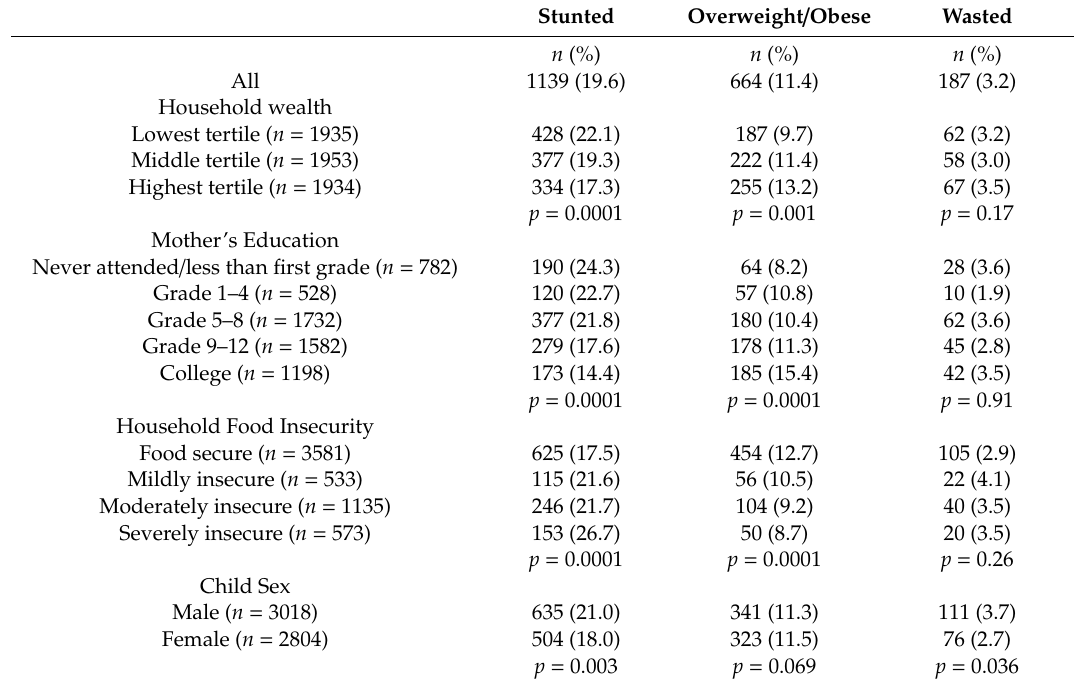
Table 2. Prevalence of child malnutrition by socio-economic resources in Addis Ababa,